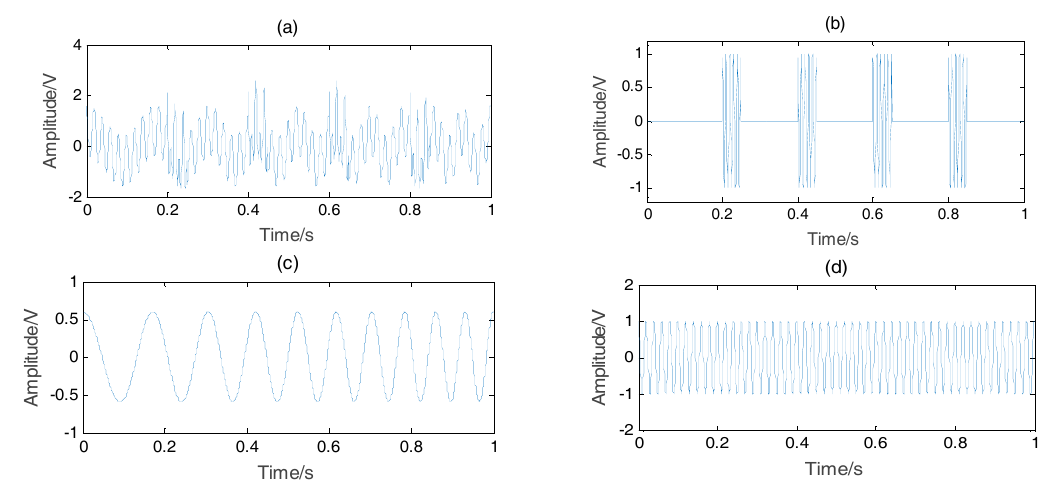
Figure 2. Simulation signals: ( a ) composite signal y ( t ) ; ( b ) interval signal x 1( t ) ; ( c ) linear frequency modulation signal x 2( t ) , and ( d ) cosine signal x 3( t ).